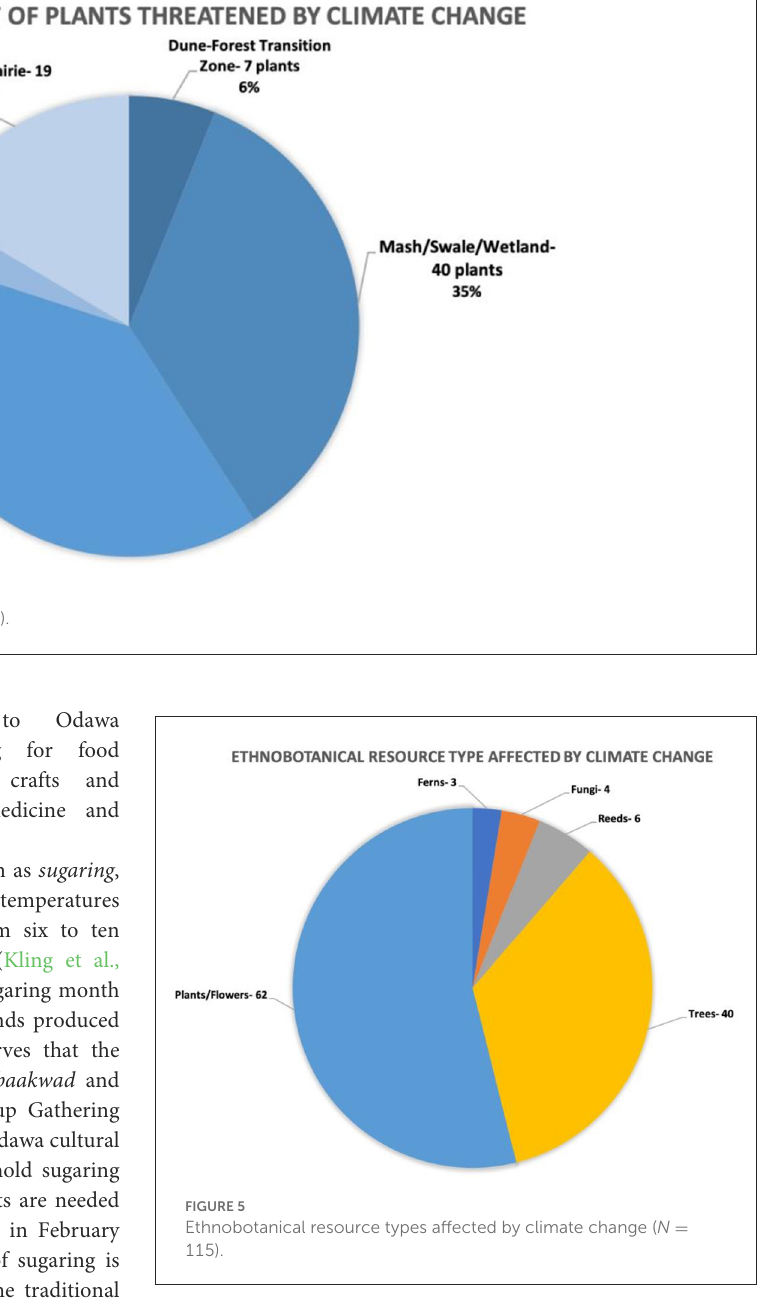
FIGURE5 Ethnobotanical resource types affected by climate change ( N =